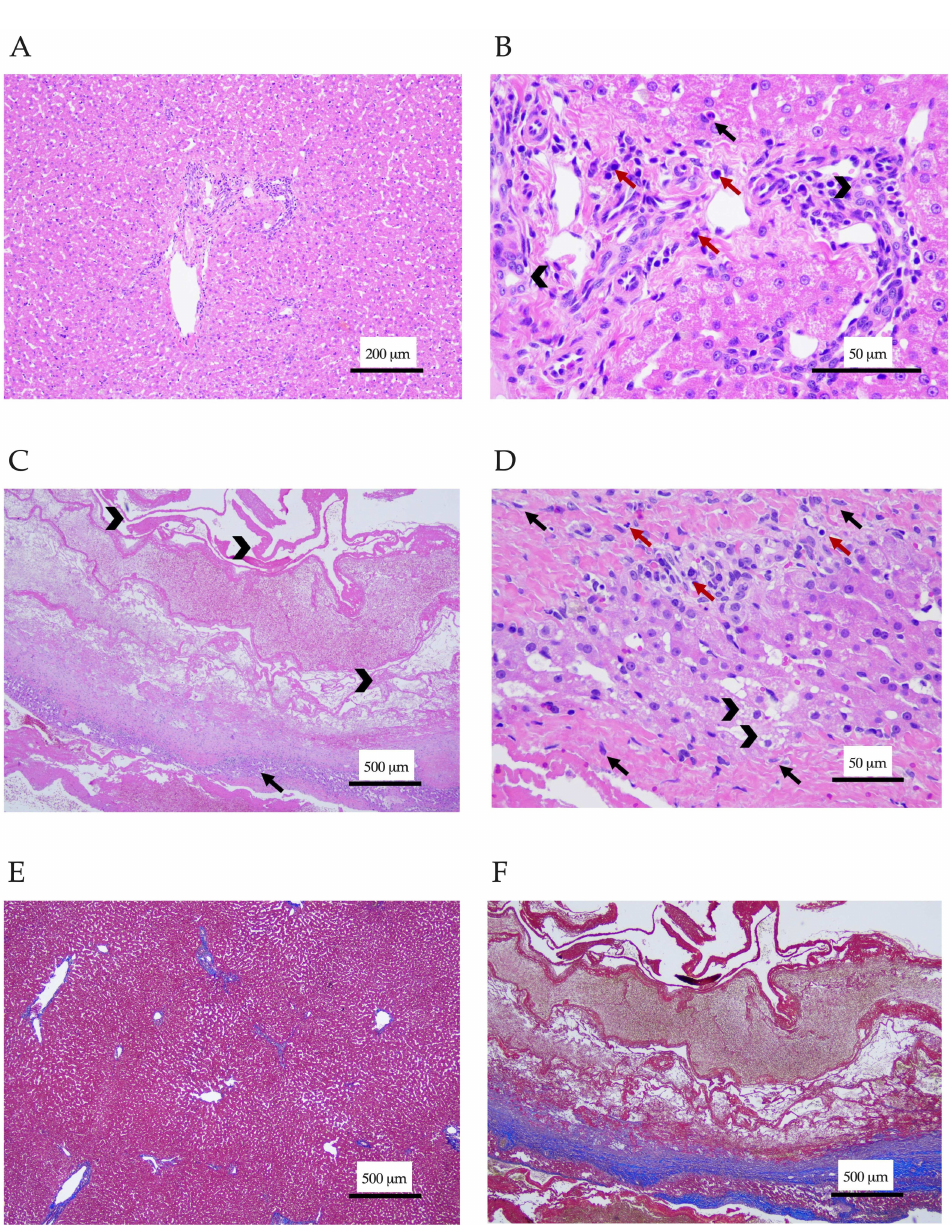
Figure 2. Histological section of the liver and cyst-like wall. ( A , B ) The liver section stained with hematoxylin-eosin showed infiltration of mononuclear inflammatory cells (red arrows) and neu- trophils (black arrows) in periportal areas and the hepatic parenchyma. Bile duct epithelium cells are marked with arrowheads. Magnification × 100 ( A ) and × 400 ( B ). ( C , D ) The hepatic cyst-like wall sec- tion stained with hematoxylin-eosin. ( C ) Eosinophilic fibrinous proteinaceous materials rearranged as a cyst-like wall (arrowhead). The remaining hepatic cords (arrow) were infiltrated with a mix of inflammatory cells, including lymphocytes, plasma cells, macrophages, and some neutrophils. ( D ) Hepatic cords showed vacuolar degeneration of hepatocytes (arrowhead) and fibrosis (black arrow). Inflammatory cells (red arrow) were seen. Magnification × 40 ( C ) and × 400 ( D ). ( E , F ) The liver and cyst-like wall sections stained with Masson’s trichrome. ( E ) Normal collagen deposition around the portal areas and central veins presented in the liver section. ( F ) The cyst-like wall section had severe tissue fibrosis surrounding necrotic tissues. Magnification × 40 ( E , F